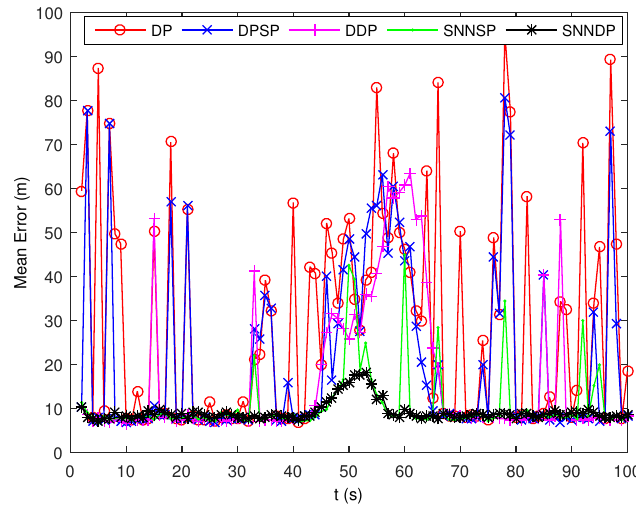
Figure 8. Mean error of estimated kinematic states.